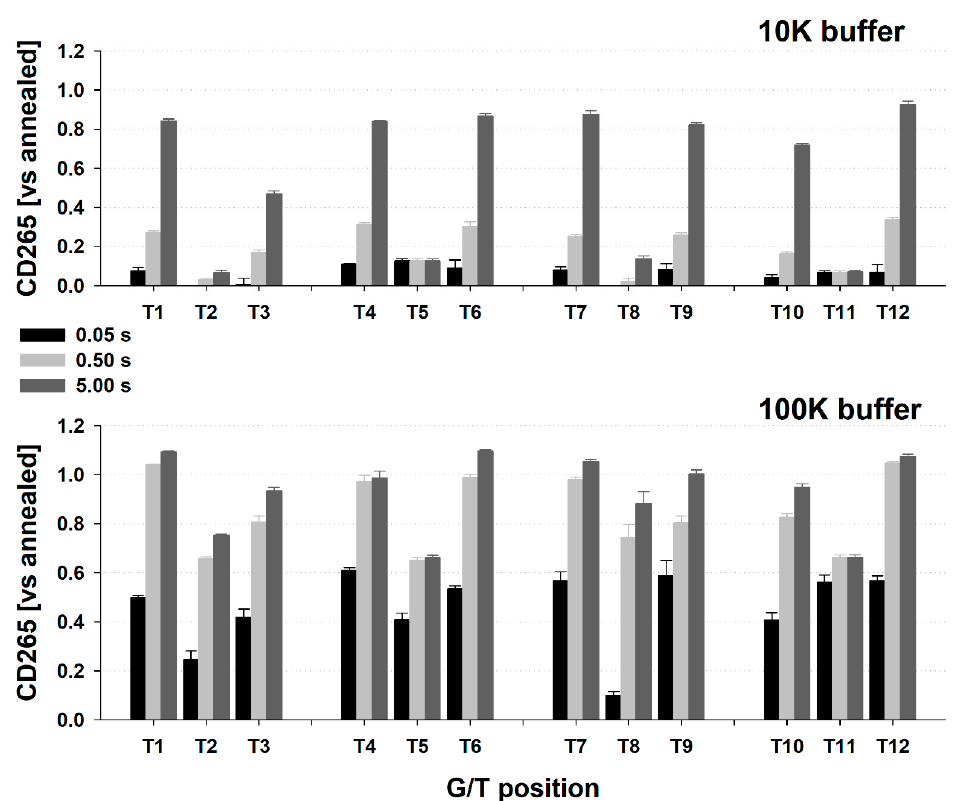
Figure 3. The relative portion of G4 folded calculated from circular dichroism for all G/T mutants in 10K (top) and 100K (bottom) buffer at various times after mixing. The values are based on Δε 265 , in 10K (top) and 100K (bottom) bu ff er at various times after mixing. The values are based on ∆ ε 265 , normalized to value observed by stopped-flow experiment mixing DNA with 1NF buffer (0) and to normalized to value observed by stopped-flow experiment mixing DNA with 1NF bu ff er (0) and to value measured after annealing in 100K buffer (1). Error bars represent standard deviations calculated value measured after annealing in 100K bu ff er (1). Error bars represent standard deviations calculated from three independent measurements. from three independent